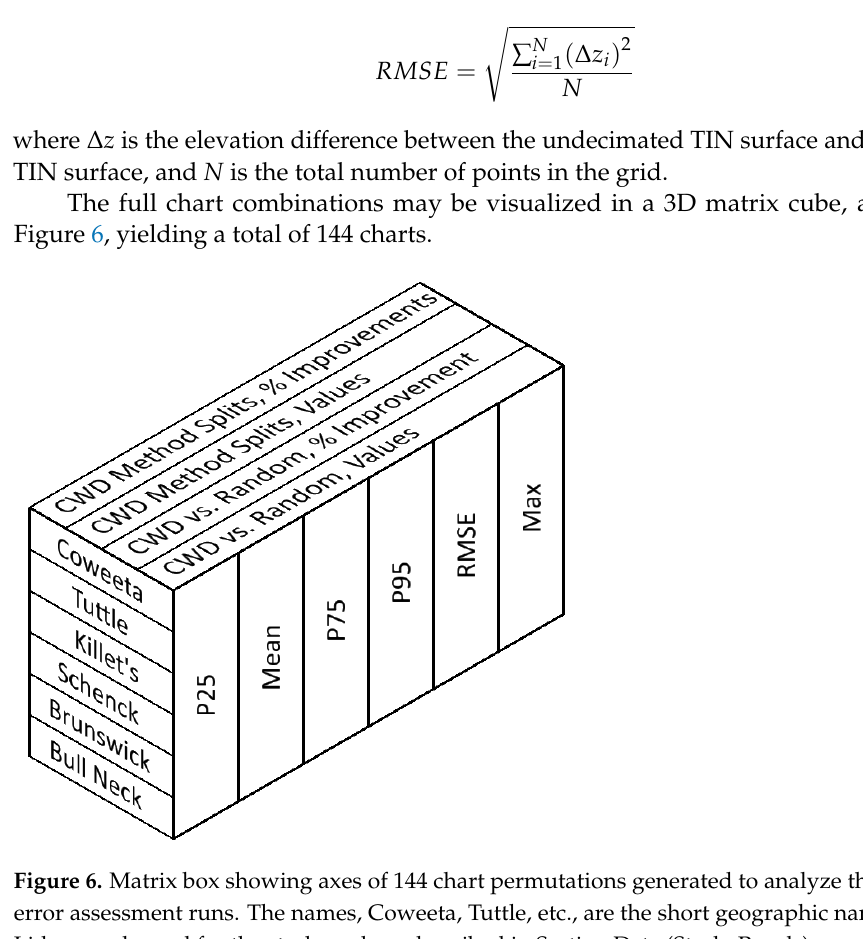
Table 4. The study uses six rectangular Lidar panels from the North Carolina Department of Public Safety, Spatial Data Download site.